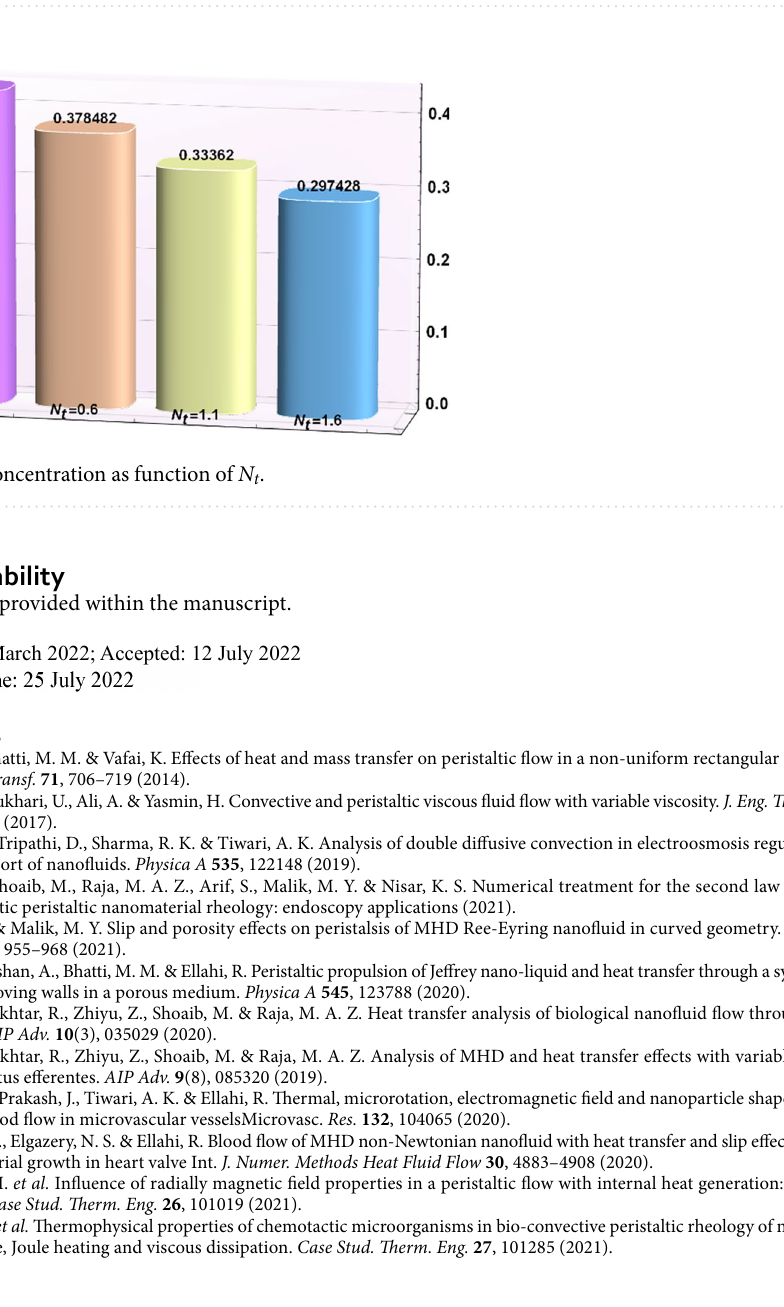
Figure 28. Temperature as function of N t .